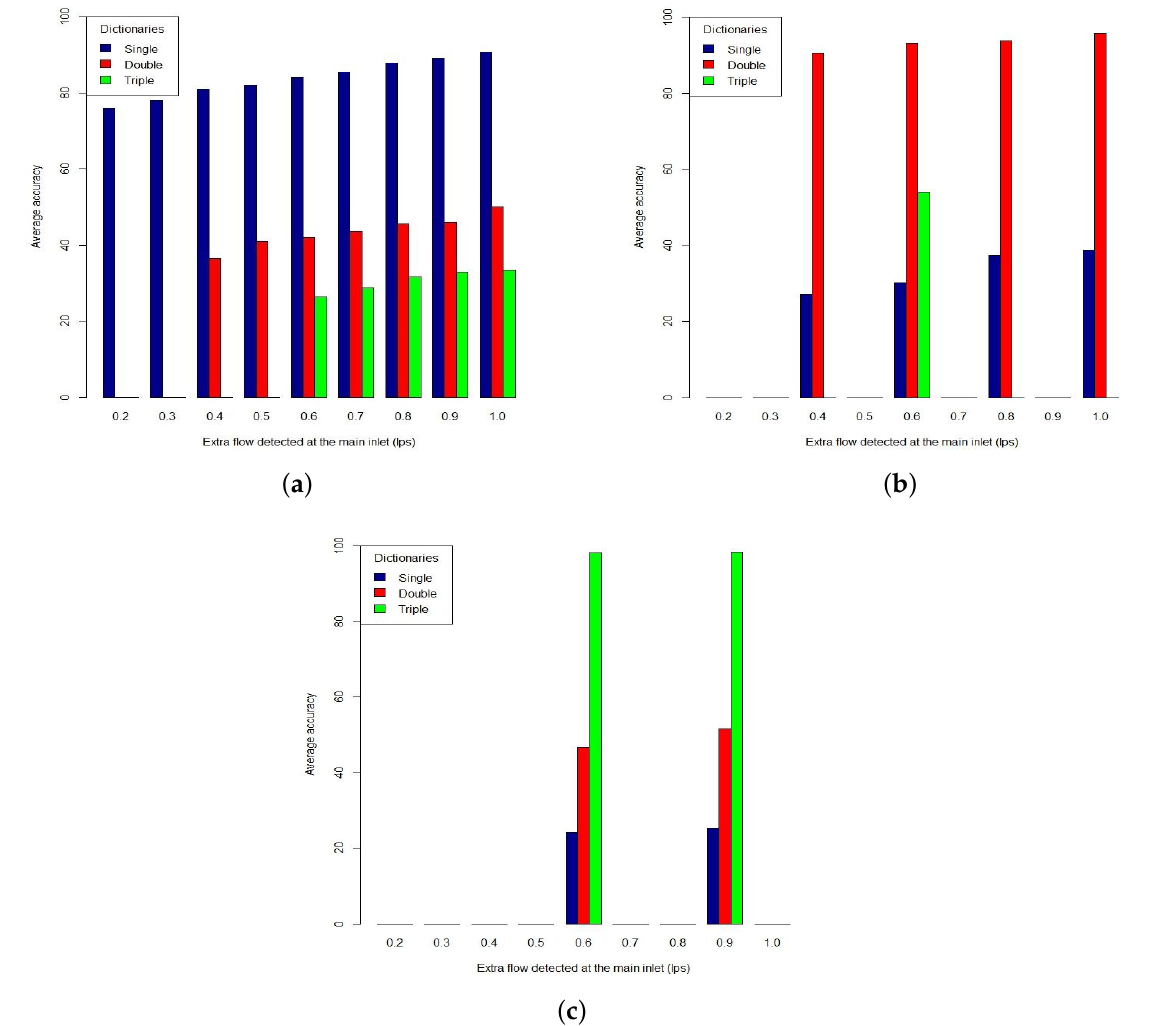
Figure 5. Average quantification accuracy of ( a ) Single ( b ) Double ( c ) Triple leaks quantified by using corresponding dictionaries.